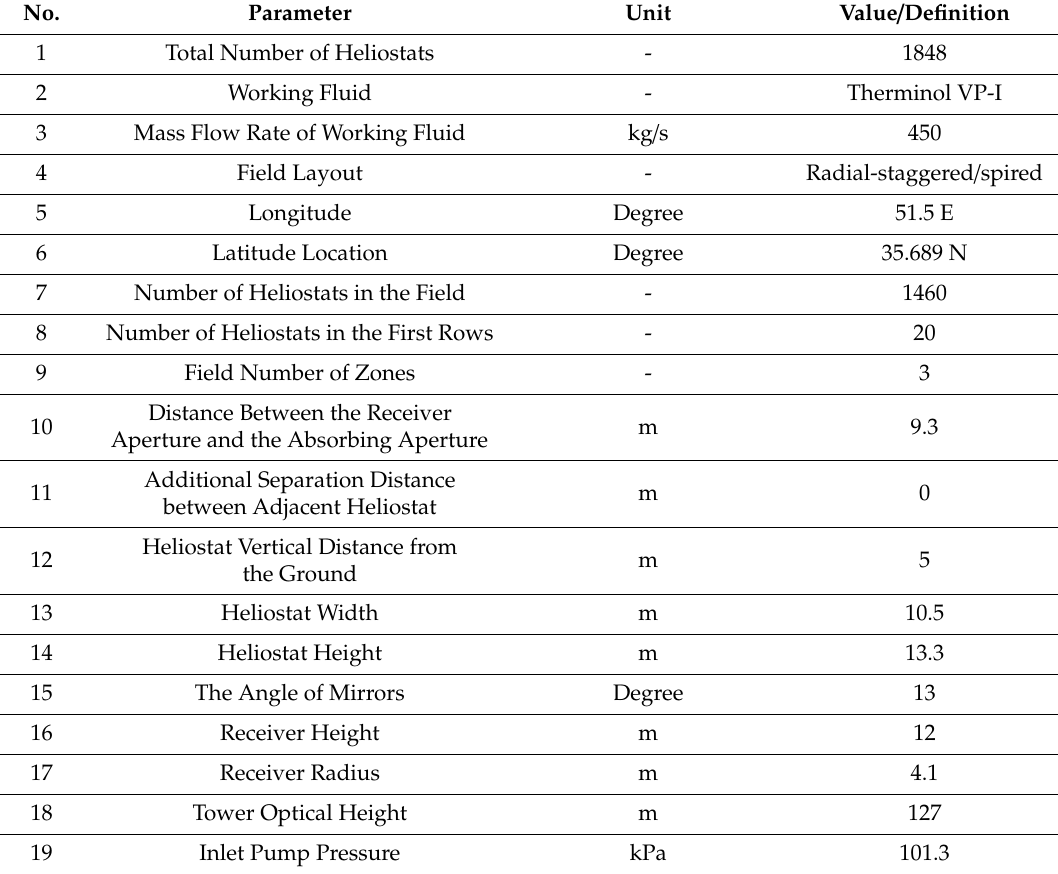
Table 8. The heliostat field solar receiver input parameters.